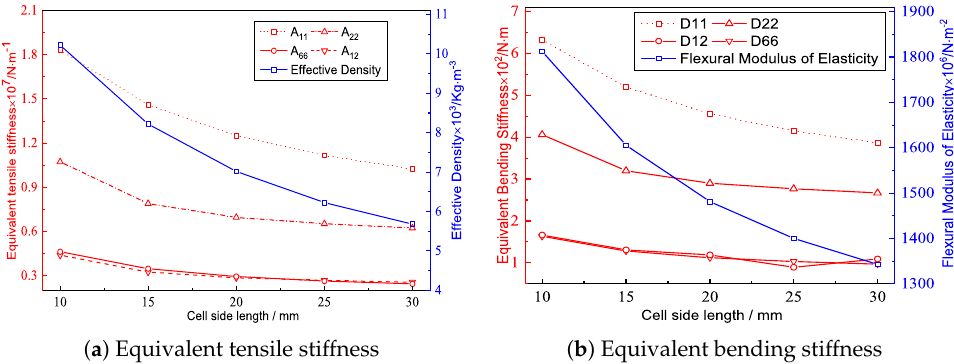
Figure 12. Effects of the cell side lengths on the equivalent stiffness of the triangular HSP.